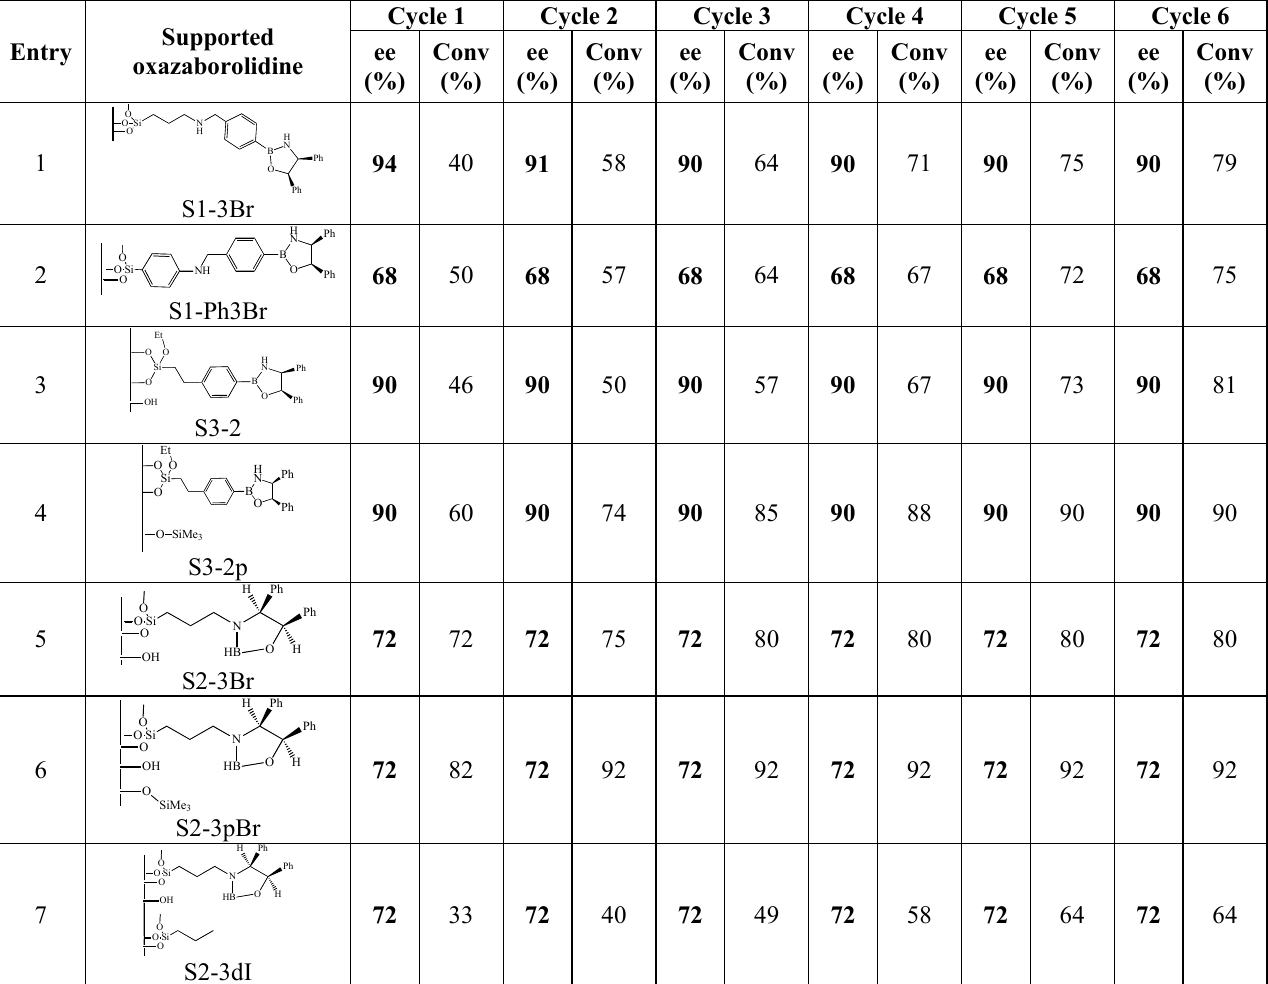
Table 9. Recycling of supported oxazaborolidine, ratio: 0.3/0.7/1(time: 2